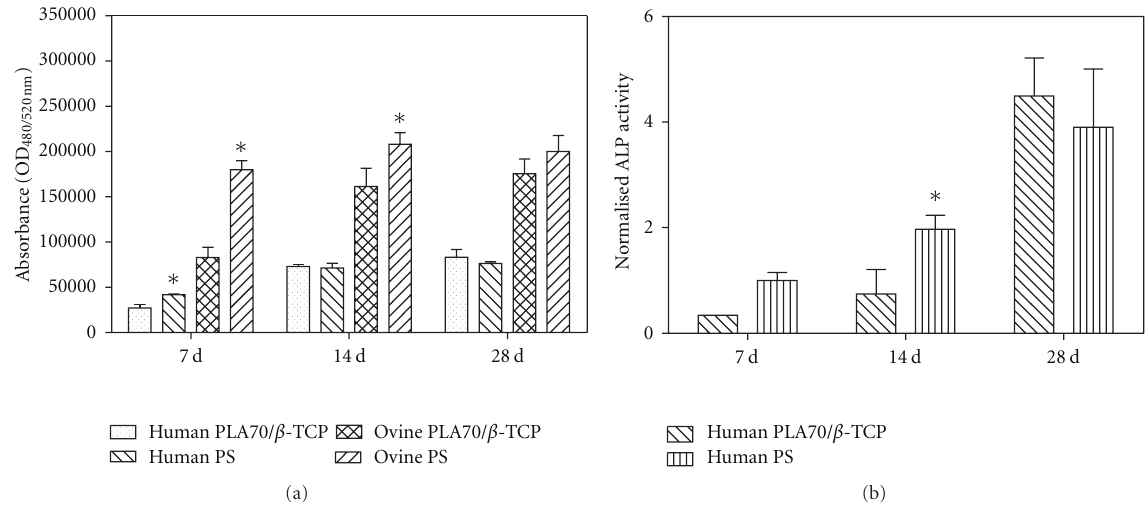
Figure 4: (a) Relative DNA content of adipose stem cells cultured for 7, 14, and 28 d on di ff erent materials measured with CyQUANT proliferation assay kit. The optical density (OD) was measured at 480/520 nm. Results are expressed as mean ± standard deviation (SD), n = 4. ∗ P < 0 . 05 with respect to corresponding composite implant (PLA70/ β -TCP). (b) Alkaline phosphatase (ALP) activity of human adipose stem cells cultured for 7, 14, and 28 d on di ff erent materials measured with ALP activity kit. Results are expressed as mean ± SD, n = 4. ∗ P < 0 . 05 with respect to corresponding PLA70/ β -TCP.